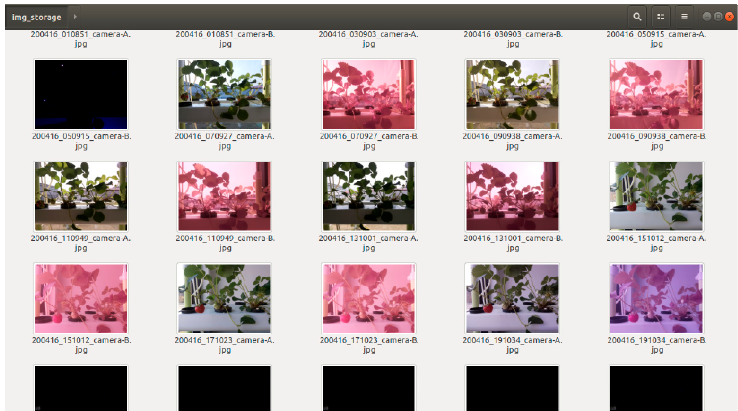
Figure 5. Strawberry photos stored on the Image Storage Server.